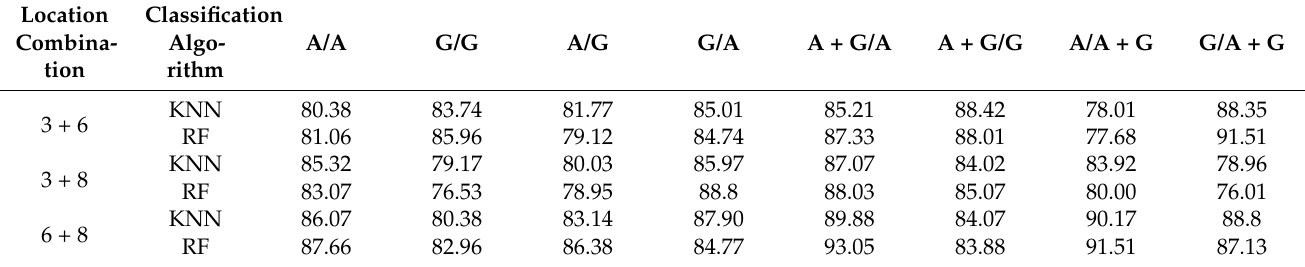
Table 5. Evaluation of the accuracy of the recognition model of two-position fusion inertial sensors.